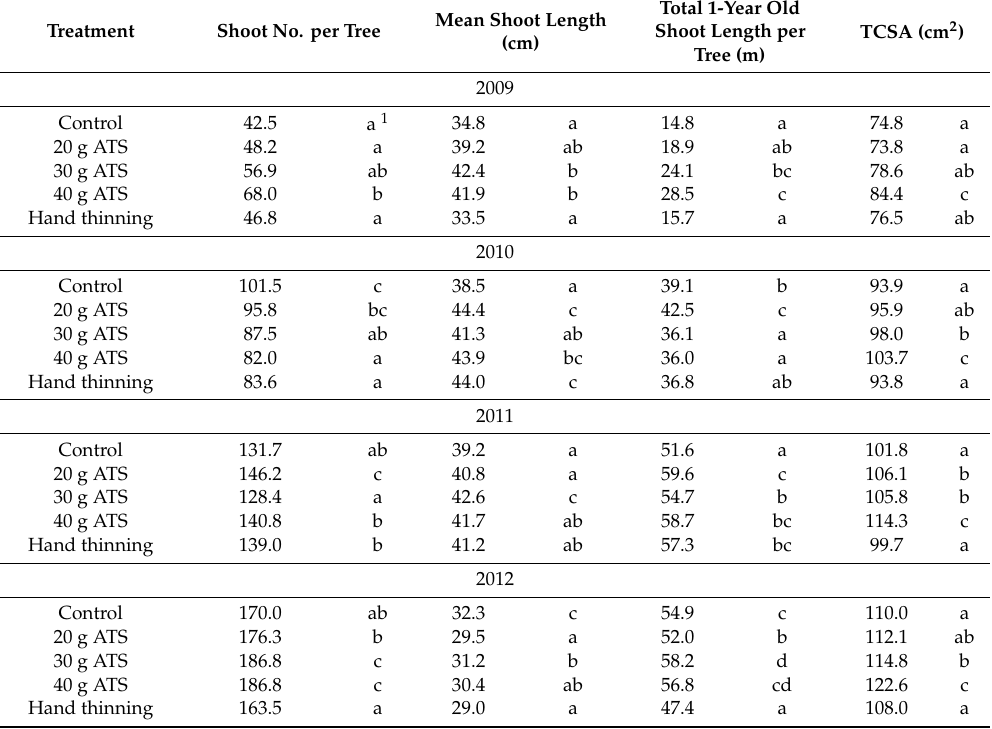
Table 9. The e ff ect of thinning on vigour parameters of ‘Regina’ sweet cherry trees in 2009–2012. Mean Shoot Length Treatment Shoot No. per Tree